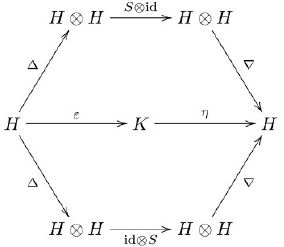
Figure 7. Commuting diagram of a Hopf bialgebra.